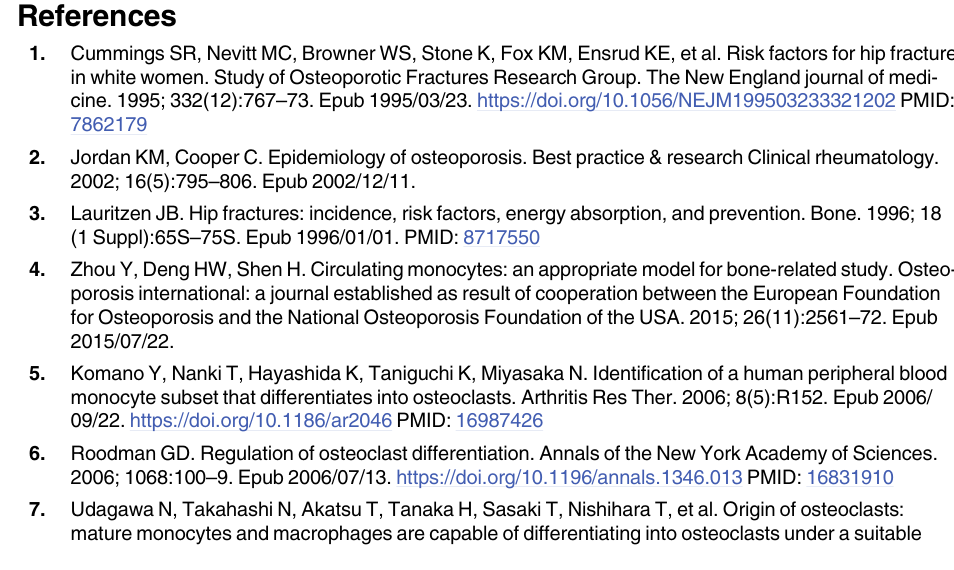
S3 Fig. Growth curve of hFOB cell cultures supplemented with human Anxa2 protein at various concentrations (0-200ng/ml). Presented are cell indexes (CI) recorded at every 10-minutes interval in real time for 36